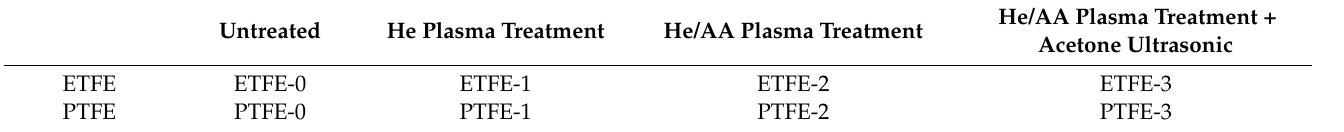
Table 1. Experimental conditions and specific sample